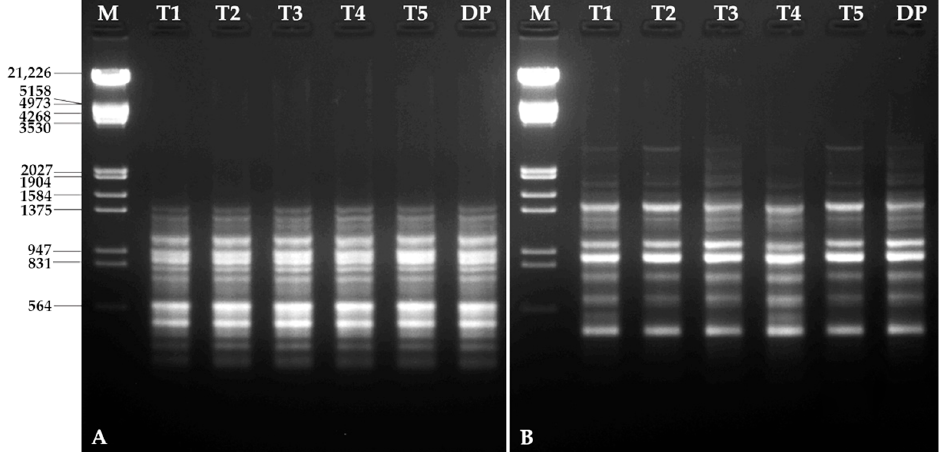
Figure 6. ISSR-PCR profiles of tissue culture and donor plants of Plectranthus amboinicus : ( A ) profile generated using primer UBC827 and ( B ) profile generated using primer UBC855. Lane M = Lambda DNA/EcoRI+HindIII marker; lanes T1–T5 = randomly selected regenerated plants; lane DP = donor